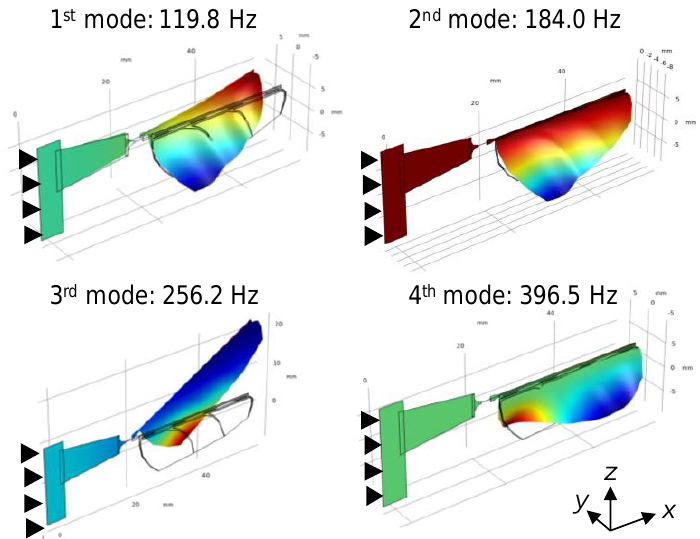
Figure A2. Resonant modes of flapping-wing actuator. Table A1. Material properties used in finite element analysis (FEA) analysis.